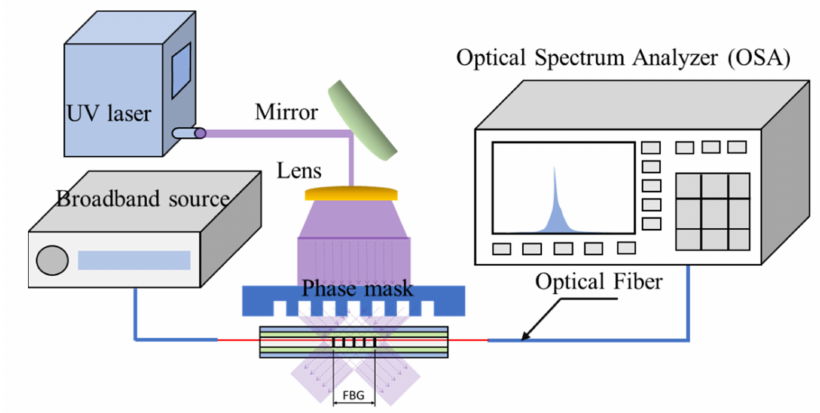
Figure 1. Using an ultraviolet laser to fabricate the FBG